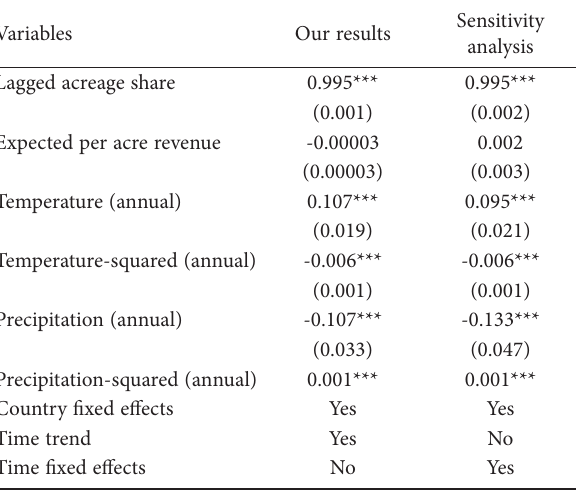
Table A.4. Estimation results for grapevines acreage: controlling for different combinations of fixed effects.